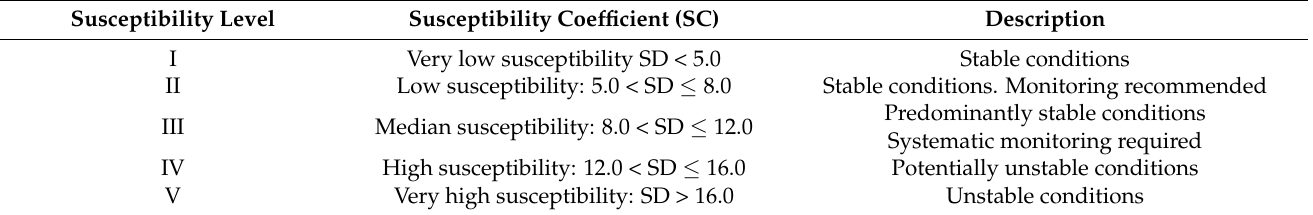
Table 7. Landslide susceptibility classification (soil). Based on [21,57,61,63,64]. Susceptibility